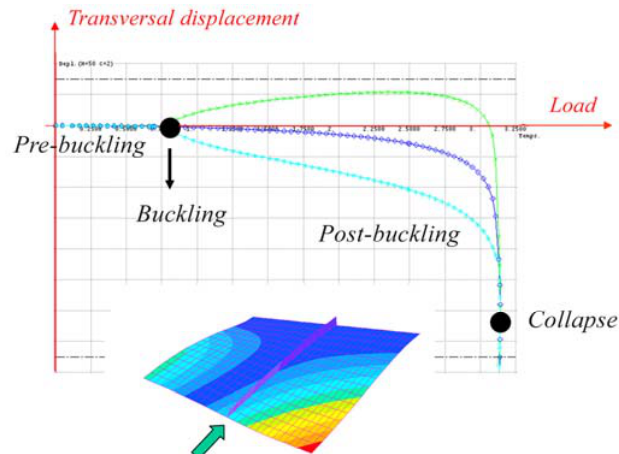
Fig. 1. Illustration of the post-buckling analysis of a stif- fened composite